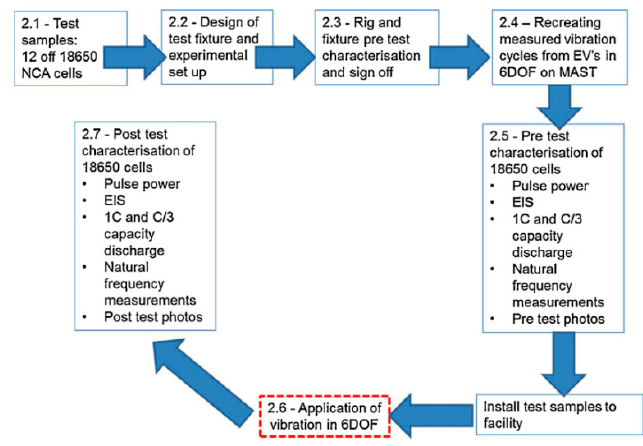
Figure 5. Schematic of test process for cells [58].